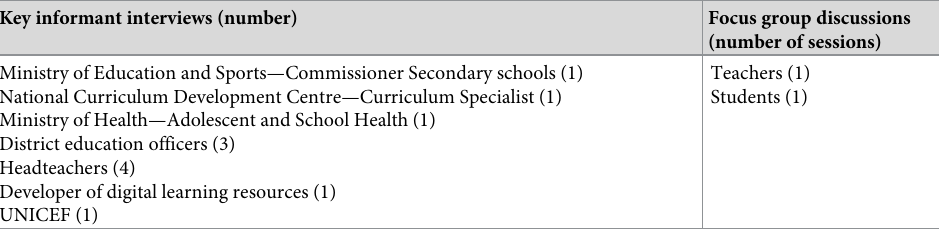
Table 2. Participant in the qualitative